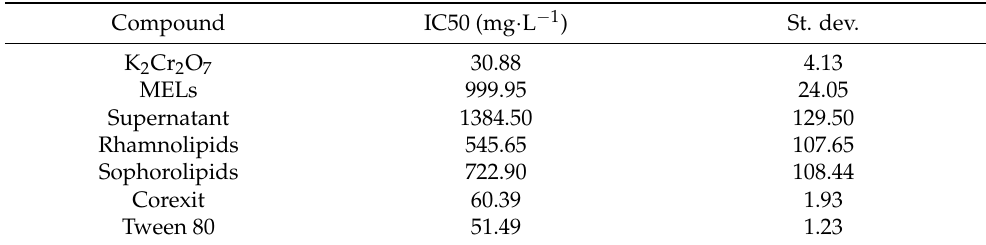
Table 2. IC50 values (with standard deviation) for various compounds for brine shrimp Artemia franciscana